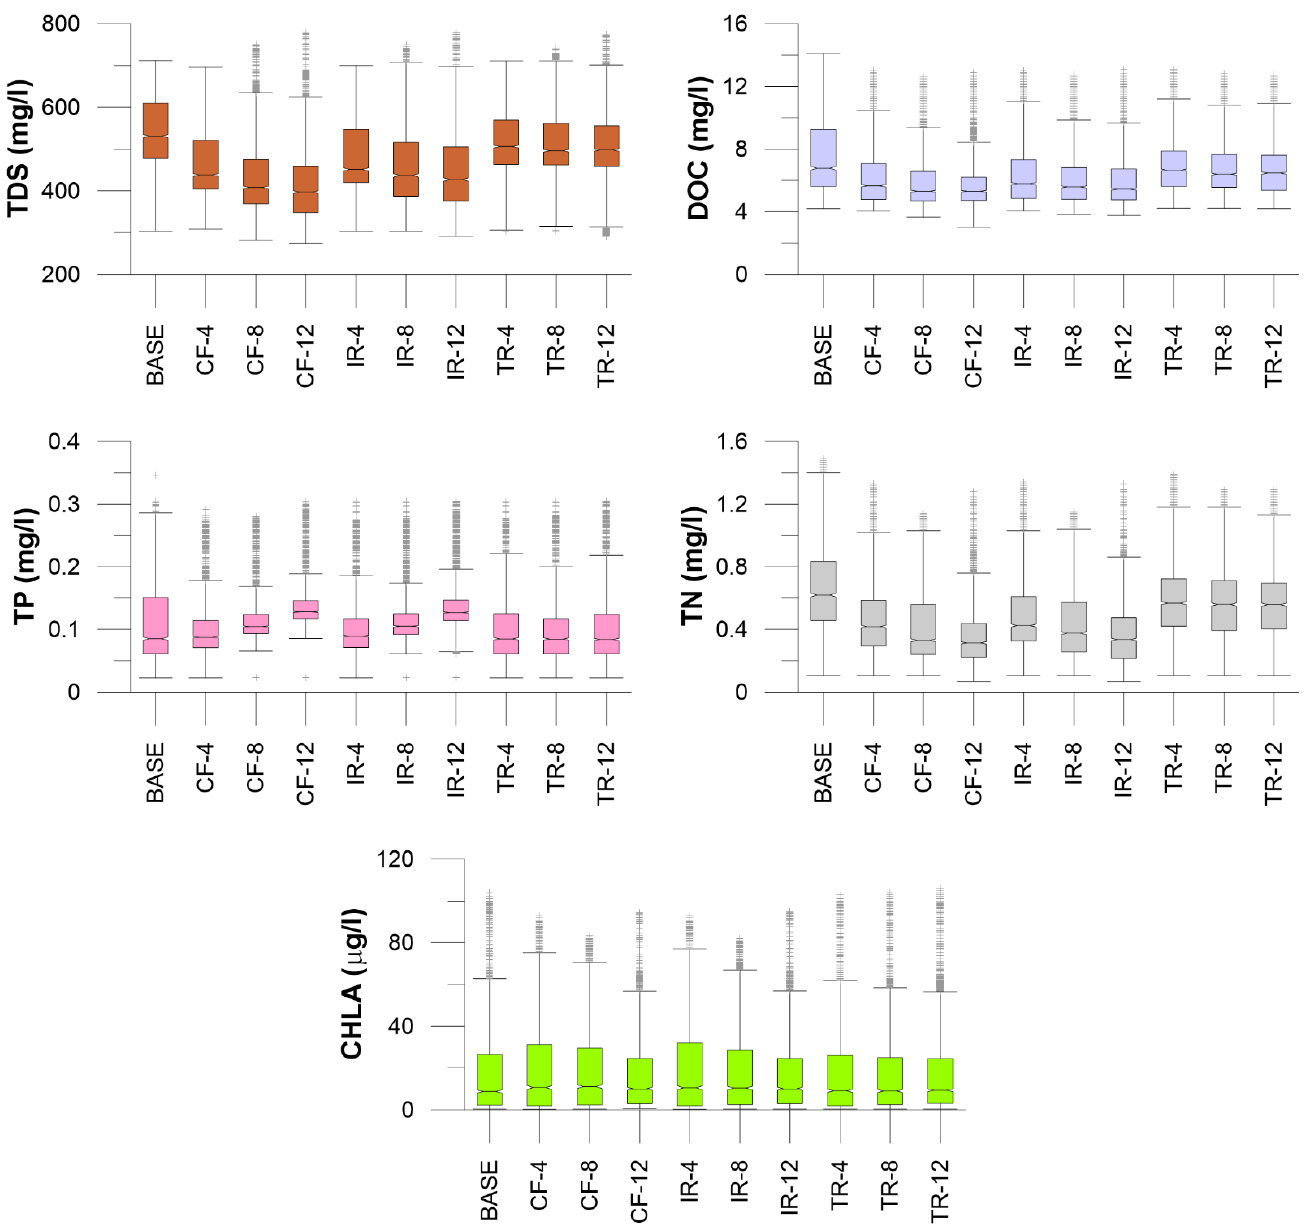
Figure 8. Boxplots comparing model output at segment 86 for the base model and the nine simulation runs for April 2013–December 2019. The box represents 50% of the ranked data (interquartile range, or IQR) with the median marked as a horizontal line within the box. Whiskers represent upper and lower bounds at (IQR ∗ factor of ±1.5).